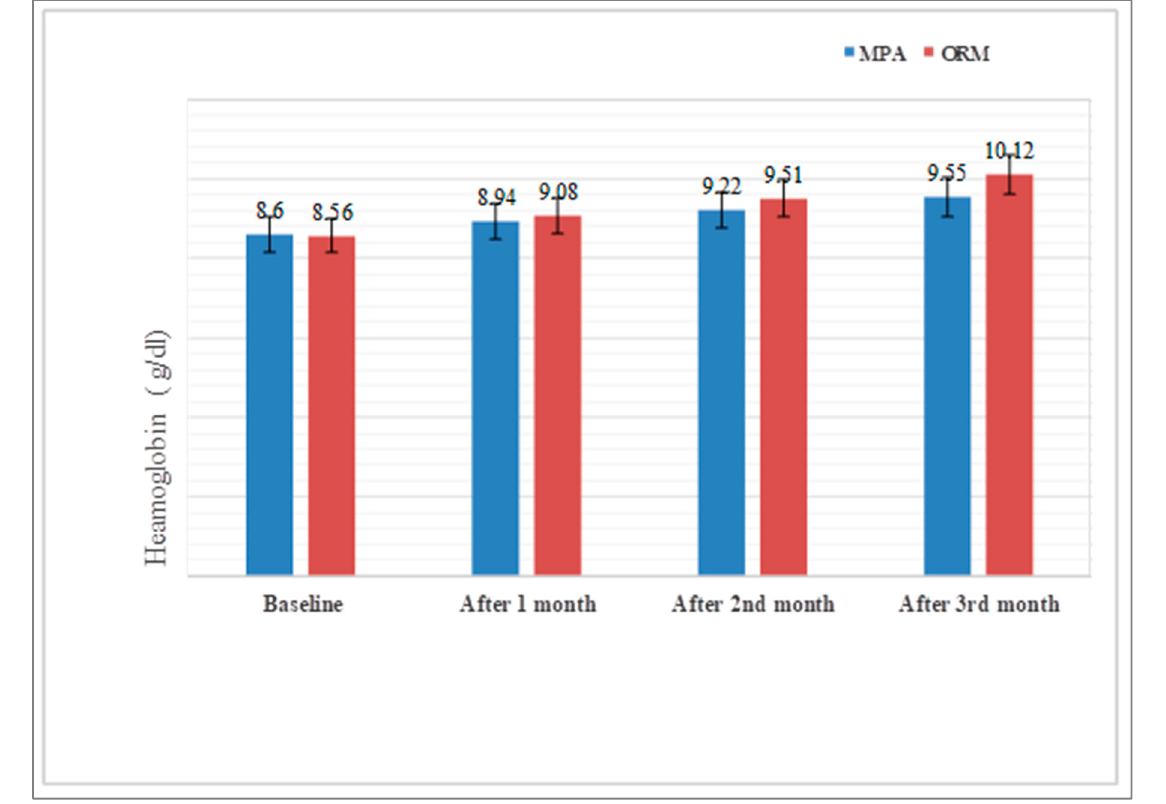
Figure 2. Comparison of haemoglobin g/dL levels before and after MPA and ORM therapy. Bars represent significance.